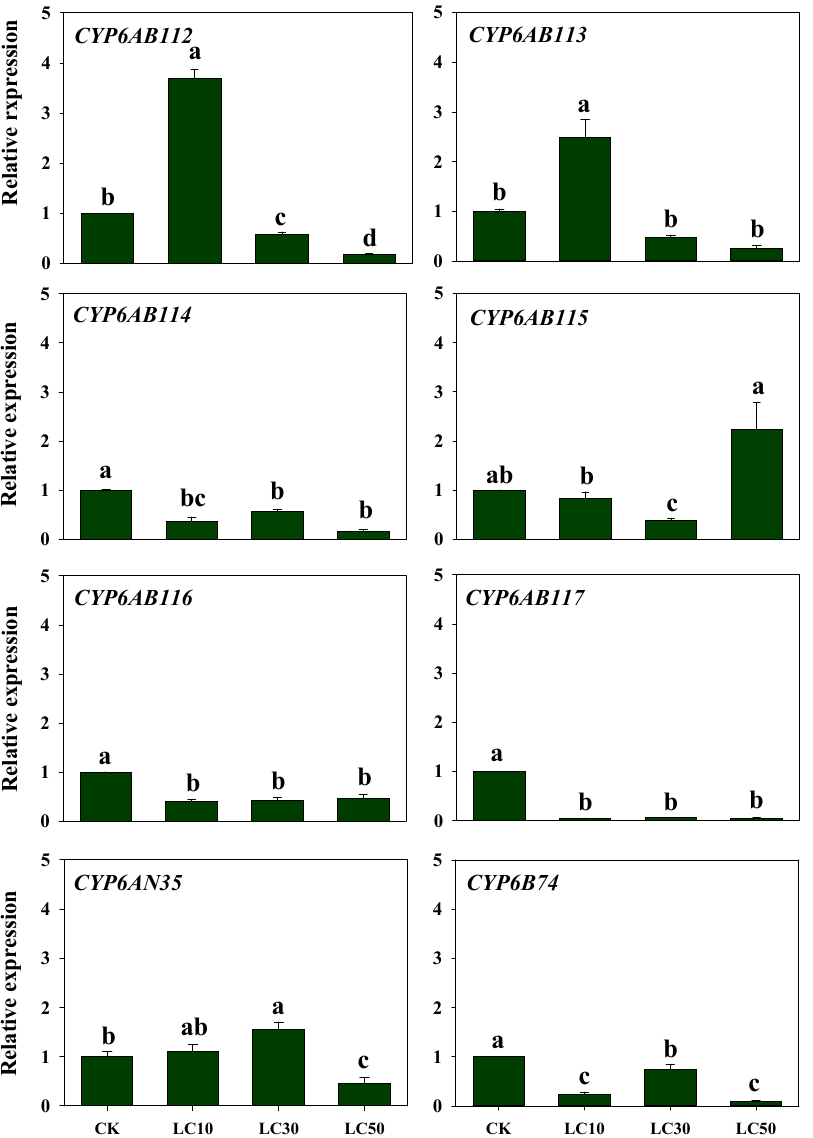
Figure 7. Relative expression of CYP6 genes in G. molesta treated with different concentrations of chlorantraniliprole. Note: control (CK), lethal concentration 10% (LC 10 ), lethal concentration 30% (LC 30 ), and lethal concentration 50% (LC 50 ). Each treatment included three biological replicates. The data in the bar charts are presented as the means ± SEs. Different letters indicate significant differences at the p < 0.05 level, as determined by ANOVA and Tukey’s HSD test.